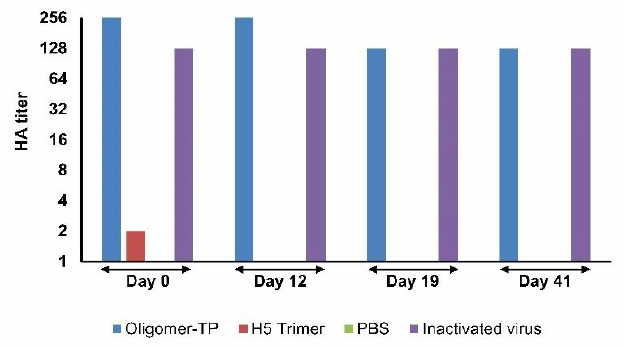
Figure 7. Stability analysis of H5 oligomers and H5 trimer crude extracts. Plant crude extracts containing either oligomer-TP or trimers were kept on ice and stored at 4 °C for 0, 12, 19, and 41 days and the hemagglutination titers were estimated. PBS and inactivated virus were included in hemagglutination tests at all time points as negative and positive controls, respectively.